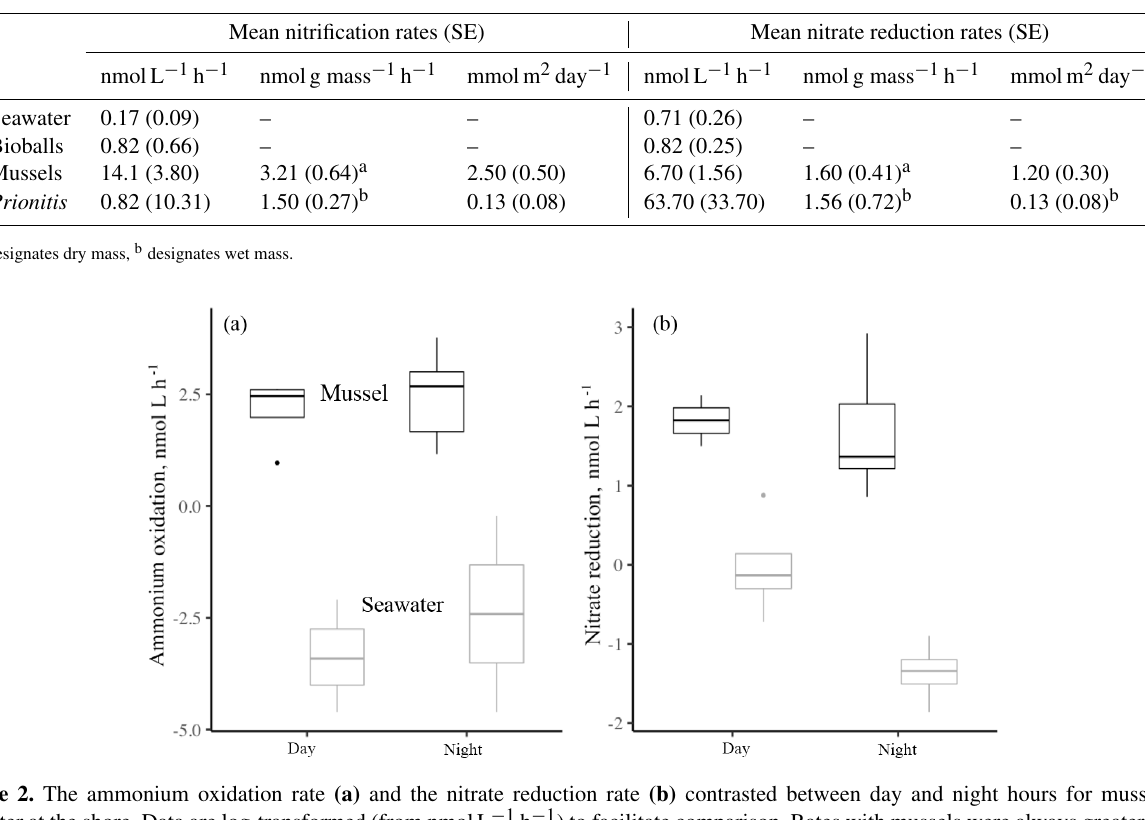
Table 1. The mean (and standard error) rates of nitrification and nitrate deduction in chambers with seawater, bioballs, mussels, and the red alga Prionitis , expressed as nanomoles (nmol) per liter per hour, nanomoles per gram mass per hour, and as a daily rate in nanomoles for a square meter of rocky shore, respectively.